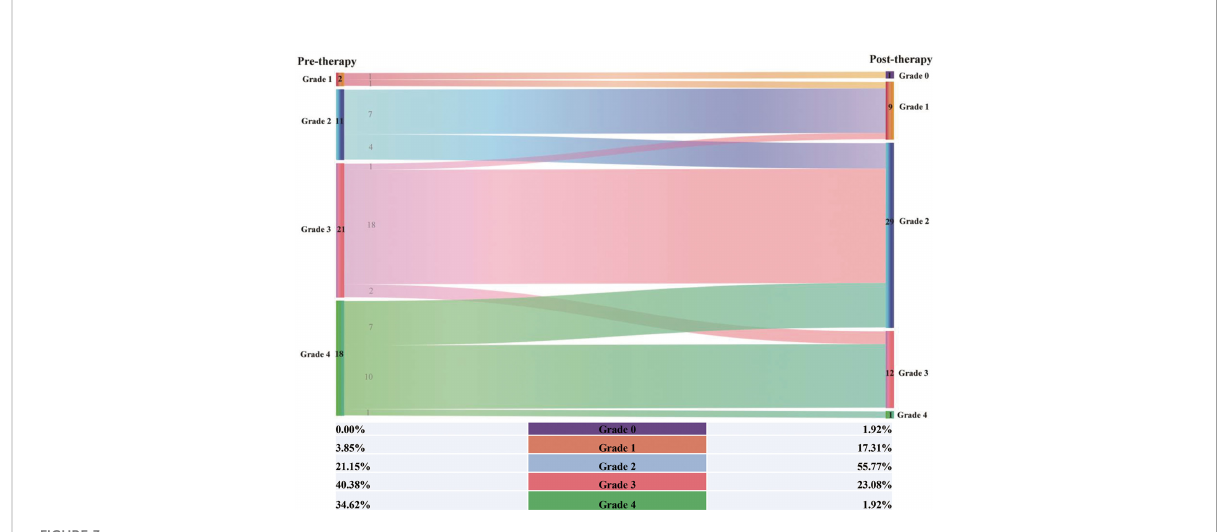
FIGURE 3 Sankey diagram of grade distribution for pre- and post- therapeutic